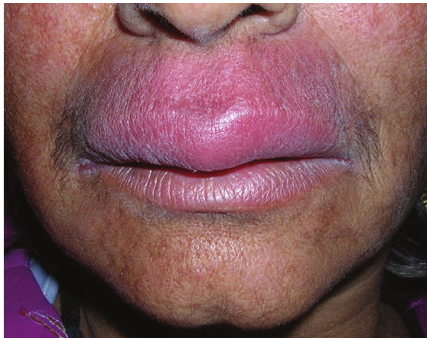
Figure 2: Histopathological pictures showing Langhans giant cells, epithelioid cells, lymphocytes, and neutrophils.